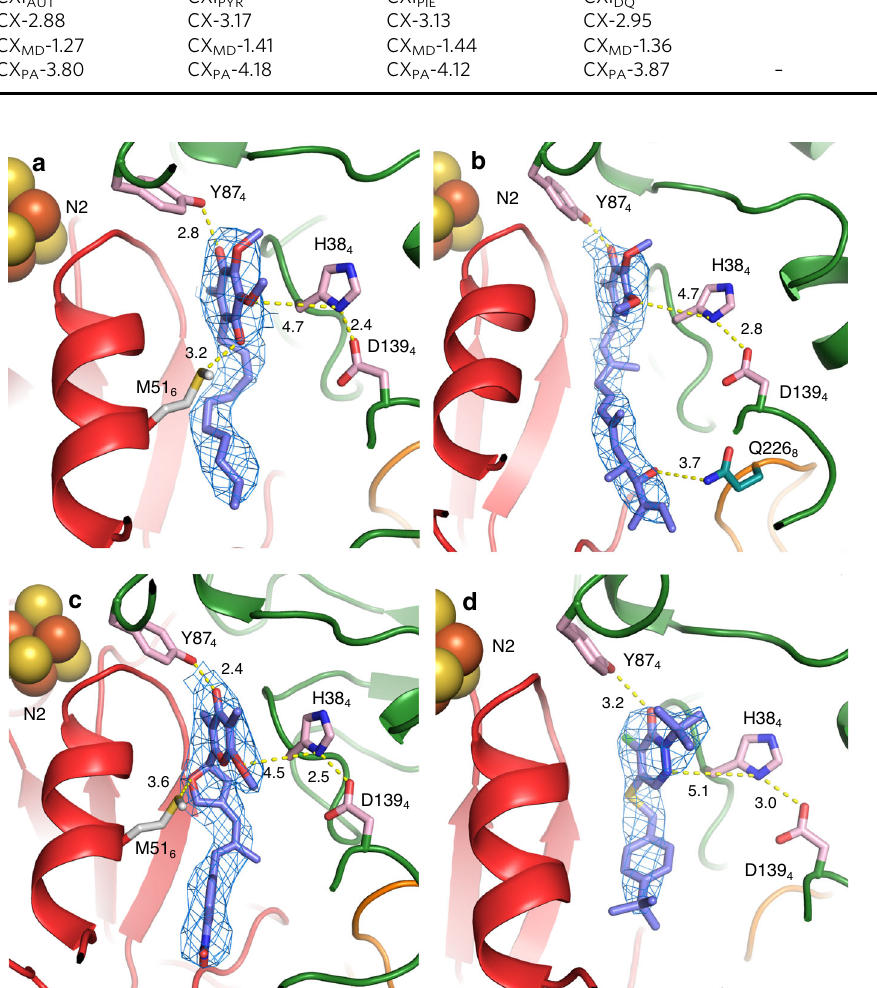
Fig. 4 Structures of ligands bound in the Q-site. 2Fo − Fc maps (at 1 σ ) and main interactions are shown, with distances in Å. Nqo4 is coloured in green, Nqo6 is in red, and Nqo8 loop is in orange. a Decylubiquinone, b piericidin A, c aureothin and d